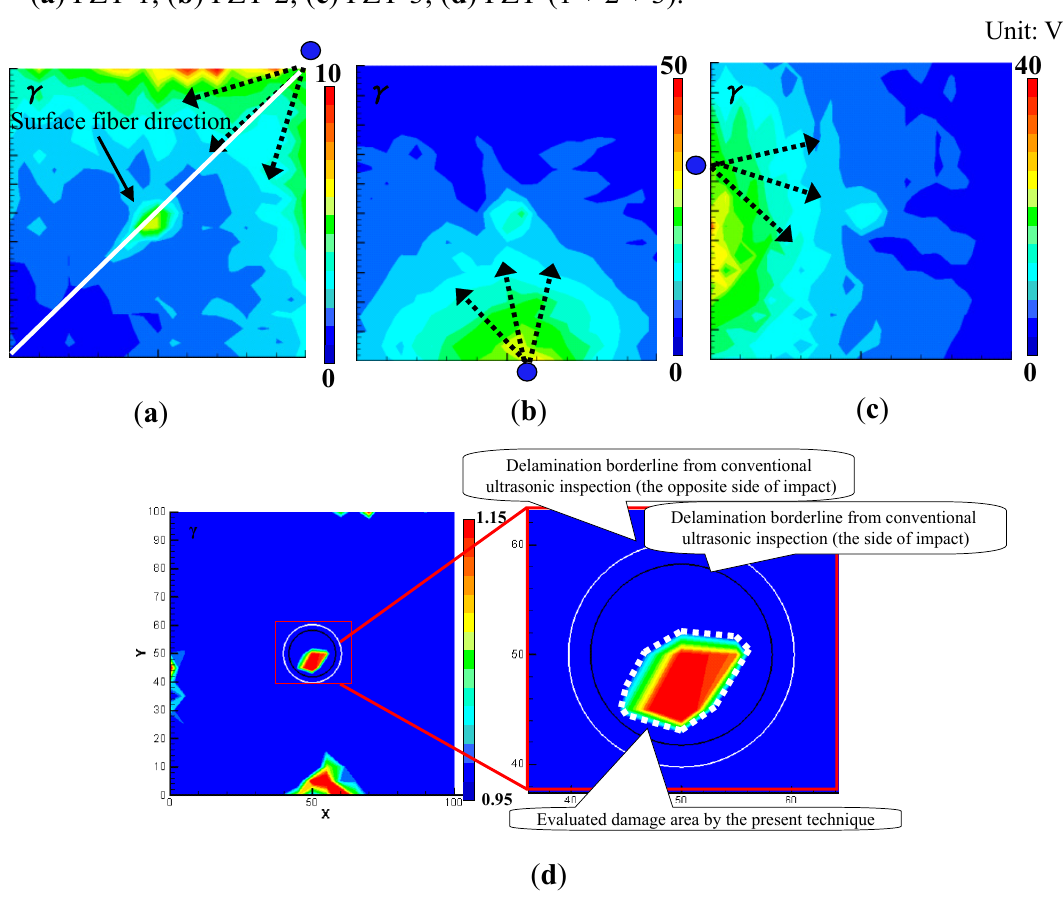
Figure 9. Experimental images of γ distribution using the present WEF map